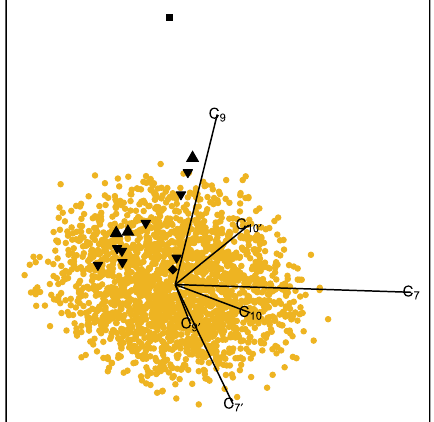
Fig. 1 Visualization of the parameter space in six dimensions via a general two dimensional projection. The set S 1 σ of points within 1 σ of the BF is shown in yellow, the black symbols mark the SM point (box); the BF point (diamond); one dimensional best fits (upwards pointing triangle); and two dimensional best fits (downwards pointing triangle). The S 1 σ cloud is seen to be separated from the SM point mostly along the C 9